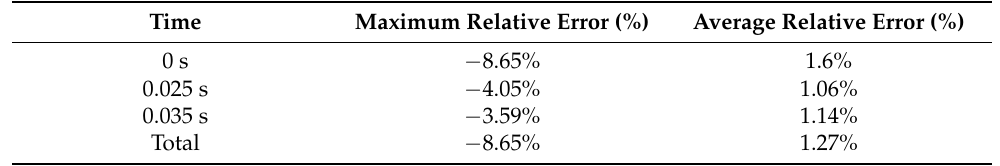
Figure 14. ( a ) Potential distribution on the cross section at 0 s; ( b ) Potential distribution on the cross section at 0.025 s; ( c ) Potential distribution on the cross section at 0.035 s. Table 11. Contrast of calculation results.